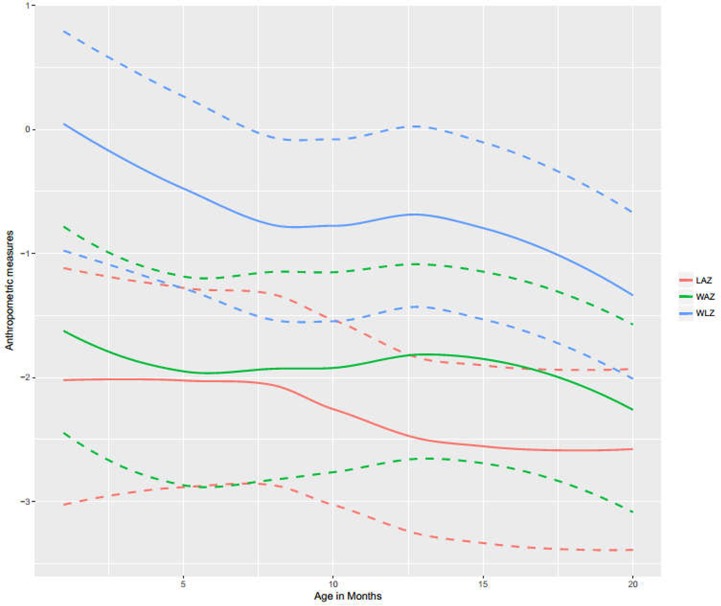
Median LAZ, WLZ and WAZ scores in Pakistani infants over 18 months of follow-up.Dashed lines show q1 and q3 quartiles. Abbreviations: LAZ = Length-for-Age Z score, WLZ = Weight-for-Length Z score and WAZ = Weight-for-Age Z score.